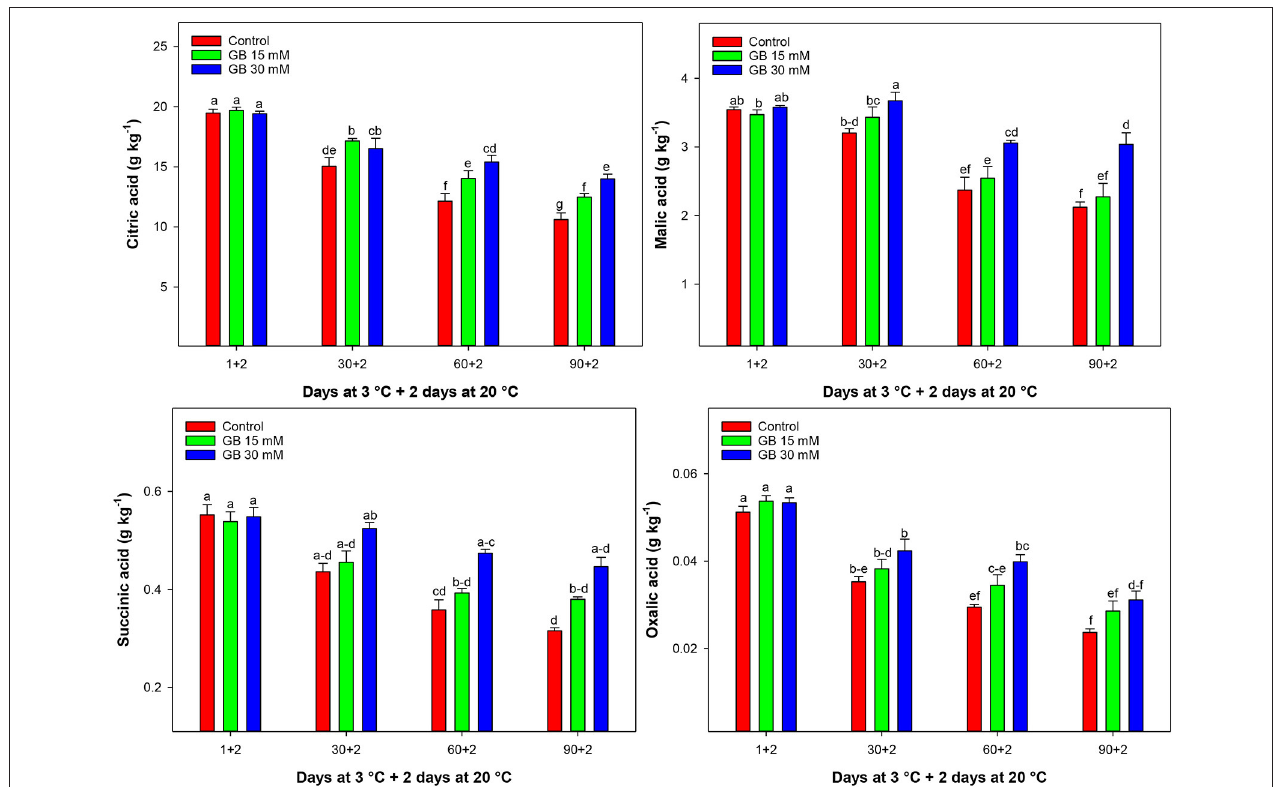
FIGURE 4 | Changes in citric acid, malic acid, succinic acid, and oxalic acid in control and GB-treated fruit of “Moro” blood orange at 3 ◦ C. Different letters and vertical bars show a significant difference ( p < 0.05) and standard errors ( ± SE) of means,